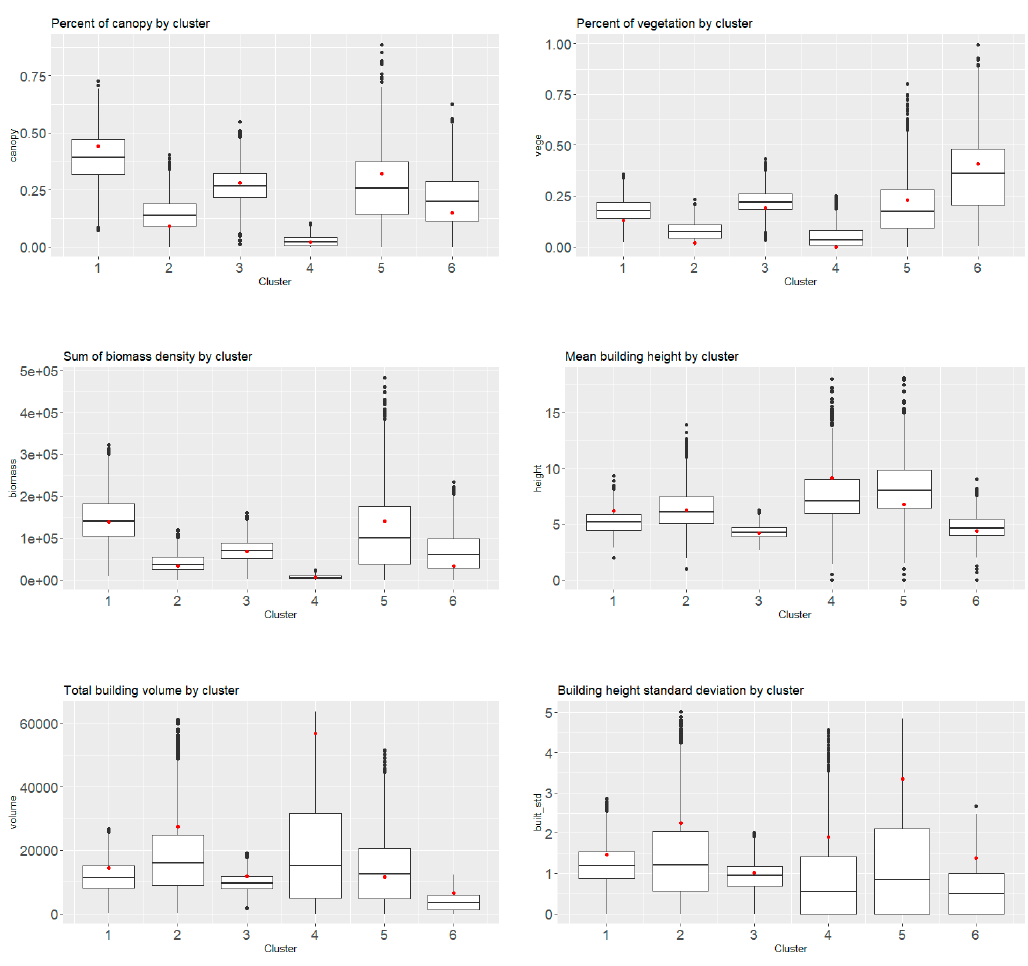
Figure 4. Data ranges for seven input variables, for each of the six final cluster selections. Red dots indicate the value for each study site.